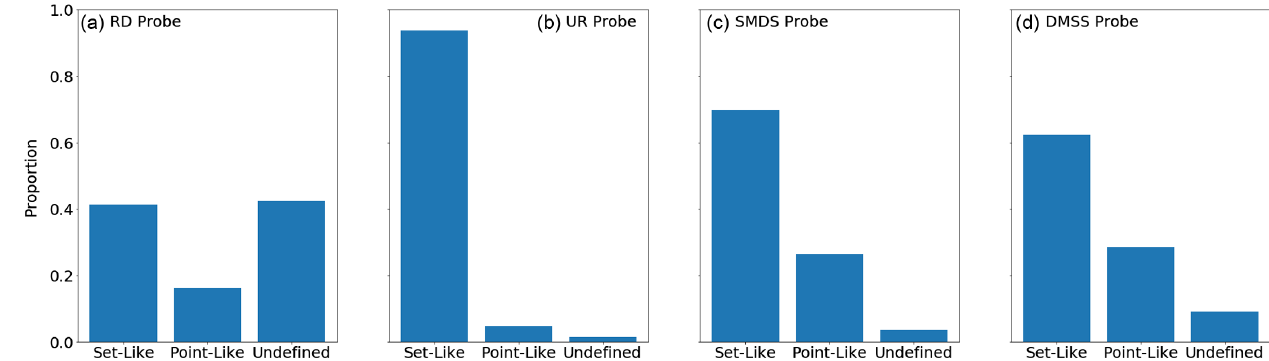
FIG. 2. Distribution of student responses classified as set, point, and undefined for each probe for the entire human-coded dataset. The UR probe responses are almost all setlike and therefore this probe has been omitted from the NLP